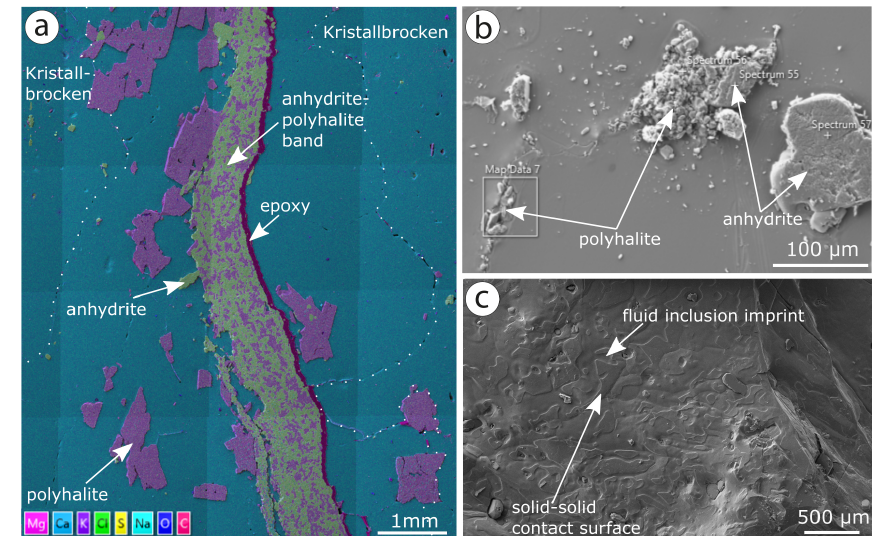
Figure 6. (a) EDS map of KS-05 (Winschoten) showing anhydrite–polyhalite band, as well as Kristallbrocken with smaller anhydrite and polyhalite inclusions. (b) SEM micrograph of polyhalite and anhydrite inclusions in fine-grained halite. (c) SEM micrograph of Kristall- brocken broken along grain boundary showing fluid inclusion imprints and abundant magnesium and potassium sulfate